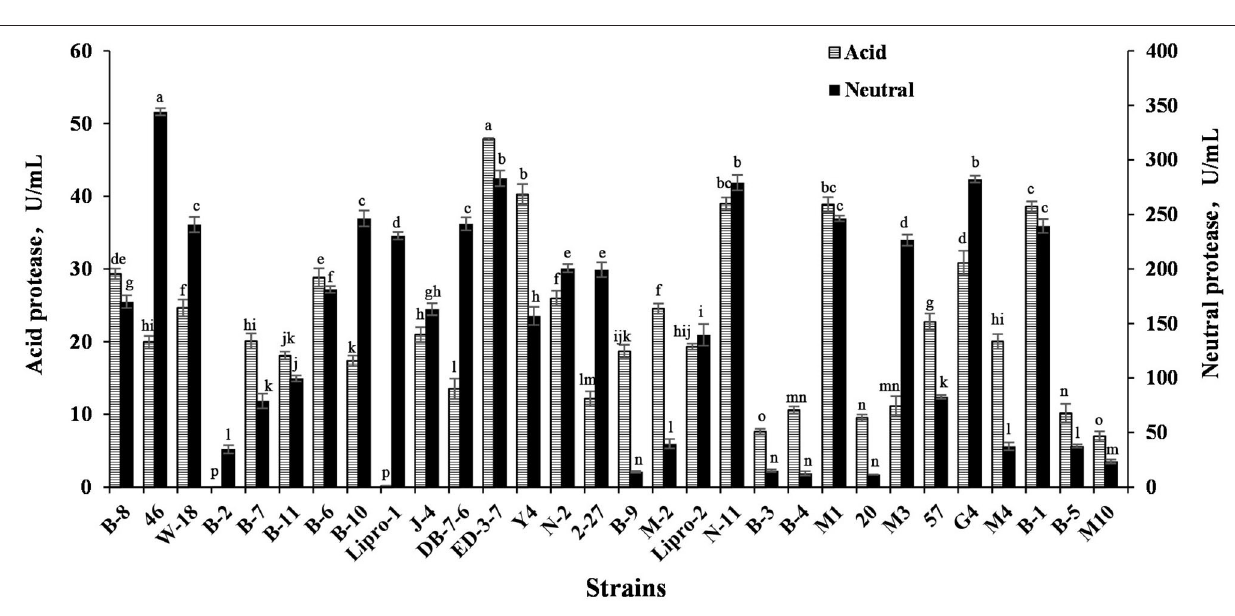
Frontiers in Nutrition |